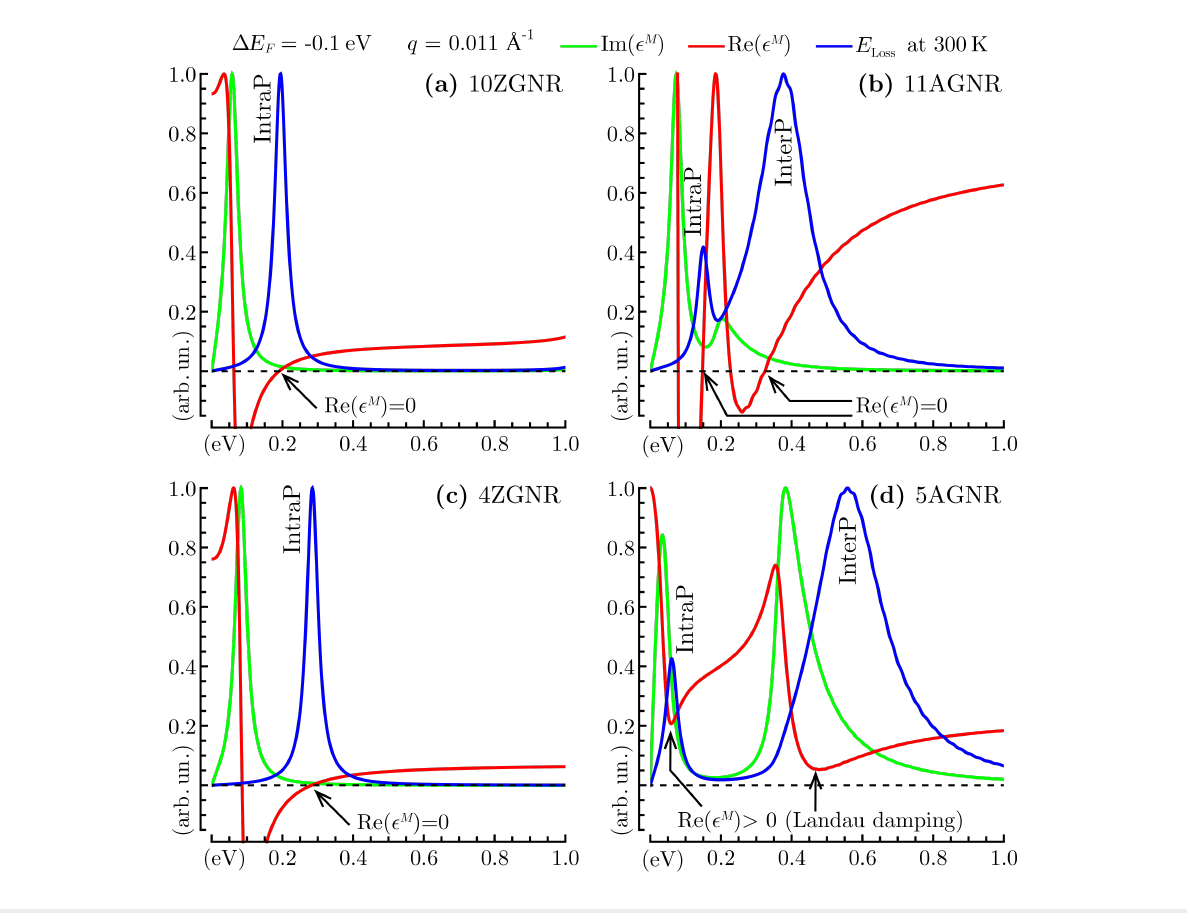
Figure 3: Macroscopic permittivity ( , Equation 6) and EL function ( E LOSS , Equation 8) at room temperature for the GNR arrays of Figure 1 and Figure 2, i.e., 10ZGNR (a), 11AGNR (b), 4ZGNR (c) and 5AGNR (d). The energy region ω ≤ 1 eV is explored at a fixed incident momentum q = 0.011 Å − 1 parallel to Γ X (Figure 2g), with a negative doping level Δ E F of − 0.1 eV. The black arrows mark the positions where the real permittivity has a zero value (a–c) or a minimum (d), which reflects a Landau damping mechanism due to single-particle excitation processes. The intraband and interband plasmons are denoted IntraP and InterP, as in Figure